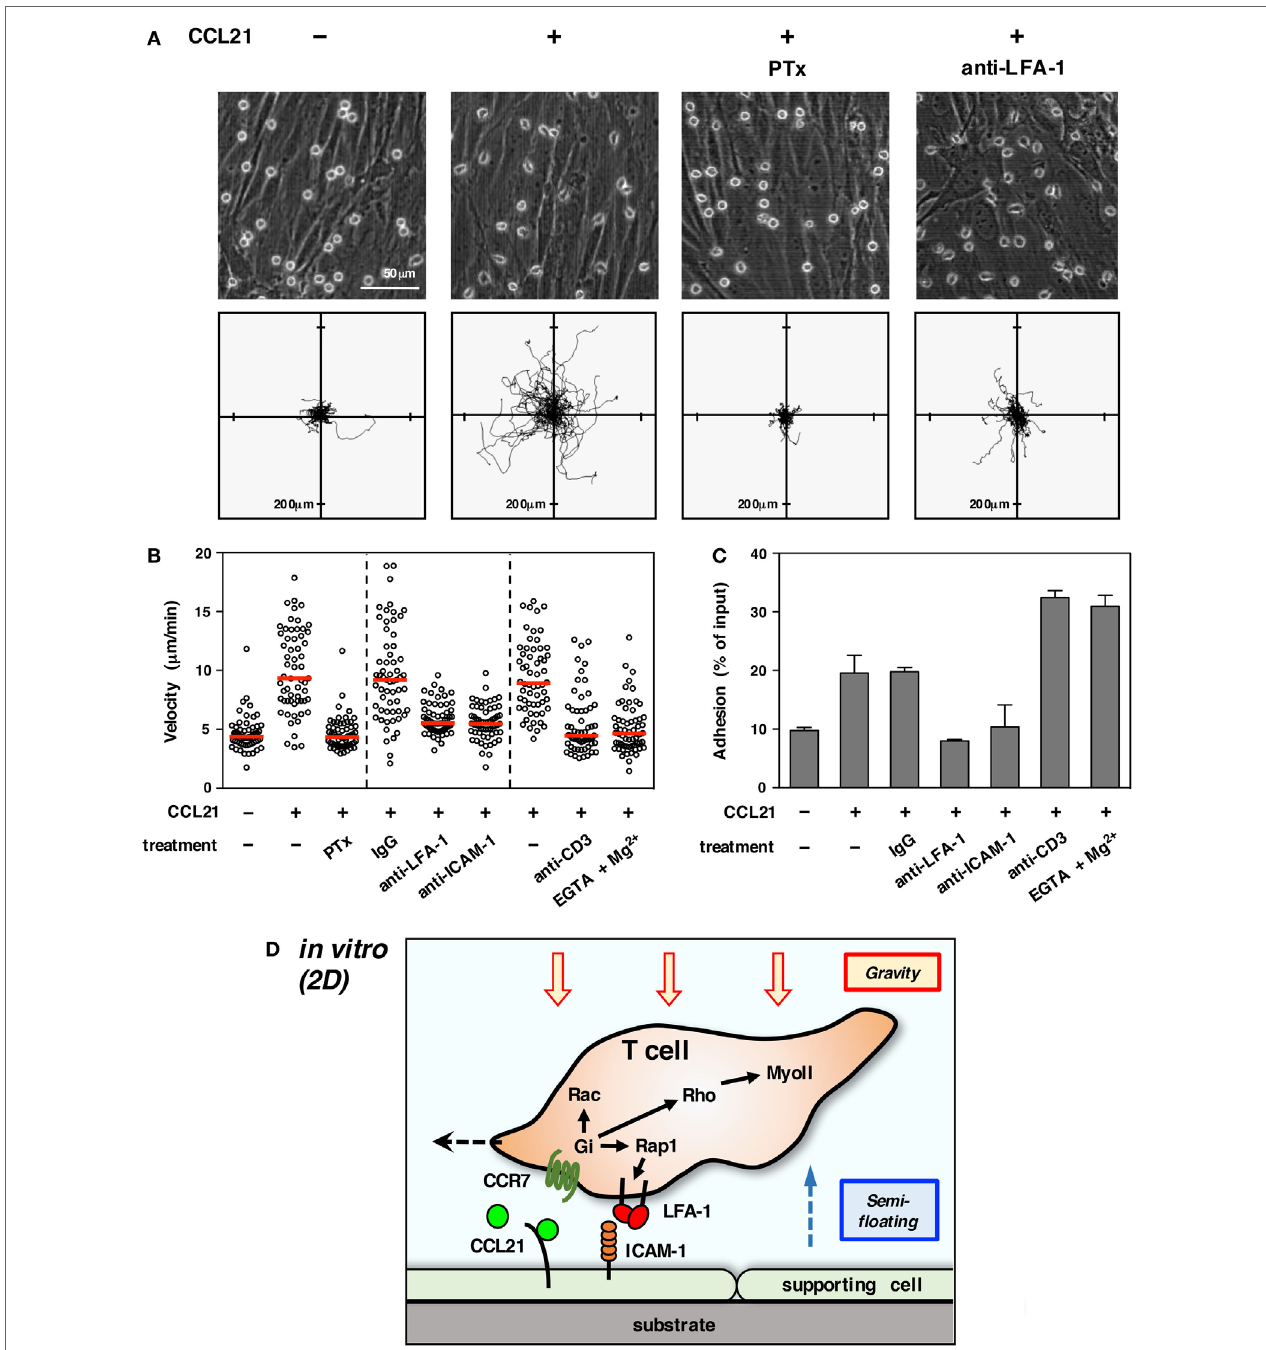
FiGUre 1 | t cell migration in vitro (2D environment) . (A) Chemokine-induced morphology and motility of T cells on primary LN stromal cells. To form a primary LN stromal cell monolayer, CD45 − cells were isolated from C57BL/6 mice LNs by magnetic cell sorting and cultured on chamber dishes for 7–10 days (27). Total T cells were isolated from LNs by magnetic cell sorting and applied onto the stromal monolayer in the presence or absence of CCL21 (100 nM). Cell motility was examined using time-lapse video recording at 37°C (28). Representative static views (upper panels) and cell trajectories (lower panels) are shown ( n ≧ 3). In some cases, T cells were pretreated with pertussis toxin (PTx) to inhibit G α i or anti-LFA-1 antibody was added to medium to block LFA-1 function. Note that CCL21 induces a characteristic polarized morphology and stimulates the motility of T cells. G α i inhibition completely abrogates both morphological changes and migration. LFA-1 blockage dramatically inhibits migration but not polarization, indicating that adhesion mediated by LFA-1 to stromal ICAM-1 is required for T cell movement in this setting. (B) Various treatments affect T cell migration on a LN stromal monolayer [partially adapted and modified from Ref. (27)]. The mean velocity of individual cells (circles) and the median (horizontal red bars). Representative results of more than three experiments are shown. Note that the inhibition of G α i completely blocks T cell migration. Antibody blockade of LFA-1 or ICAM-1 dramatically reduces motility. The treatment of T cells with anti-CD3 antibody or EGTA + Mg 2 + ,